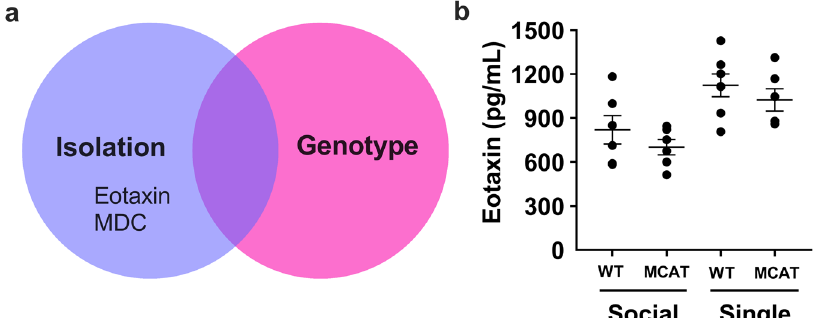
Fig. 7 Effect of isolation on plasma cytokines. a Isolation elevates the levels of Eotaxin and MDC in plasma and are not mitigated in MCAT mice. b Representative graph (Eotaxin) showing the effects of isolation on plasma cytokines and no mitigation in MCAT mice. WT NL social ( n = 6), WT NL single ( n = 6), MCAT NL social ( n = 7), and MCAT NL single ( n = 6). Some data points overlap. A fi t model was created and included housing state, genotype and loading state, and their pairwise interactions. Interaction effects between housing state and genotype were assessed at p < 0.05.